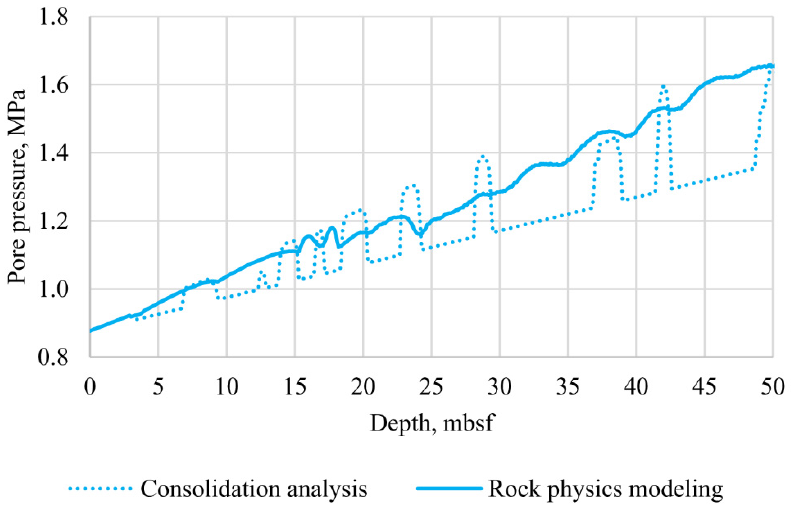
Figure 7. Pore pressure predictions using two